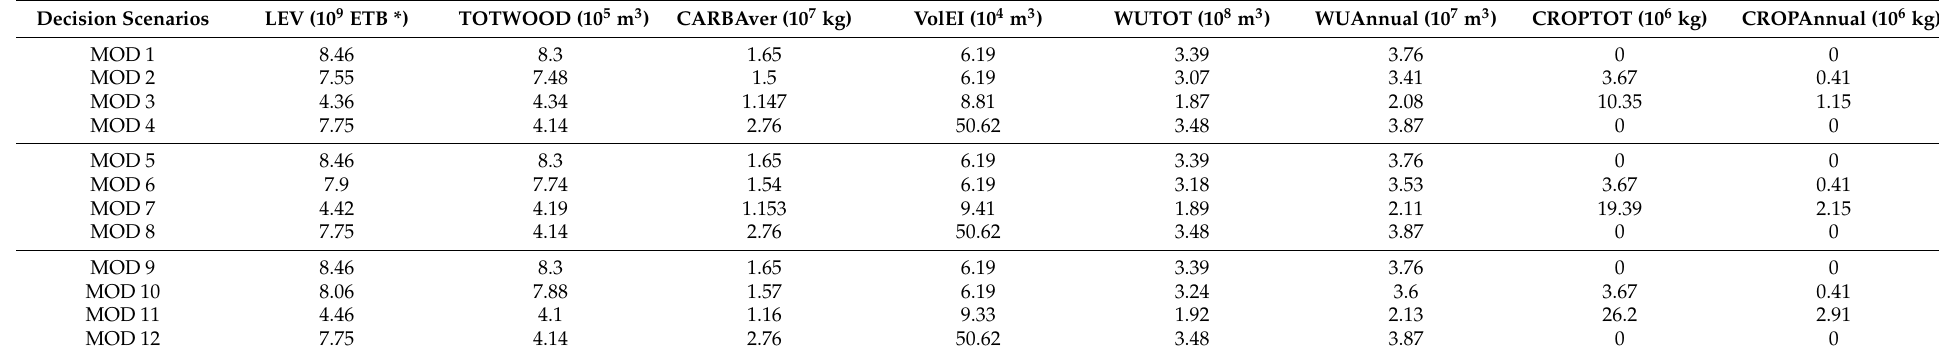
Table 2. Optimal values associated with decision